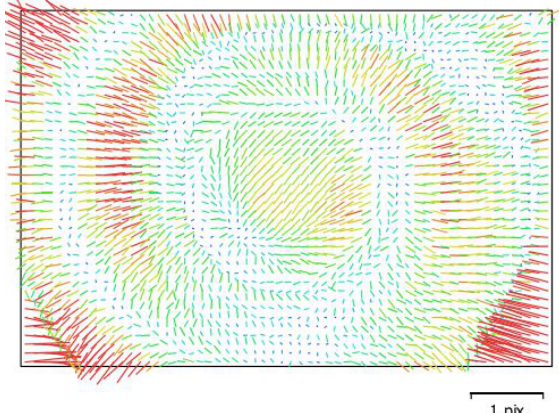
Figure 3. Image of residuals for the used S.O.D.A.